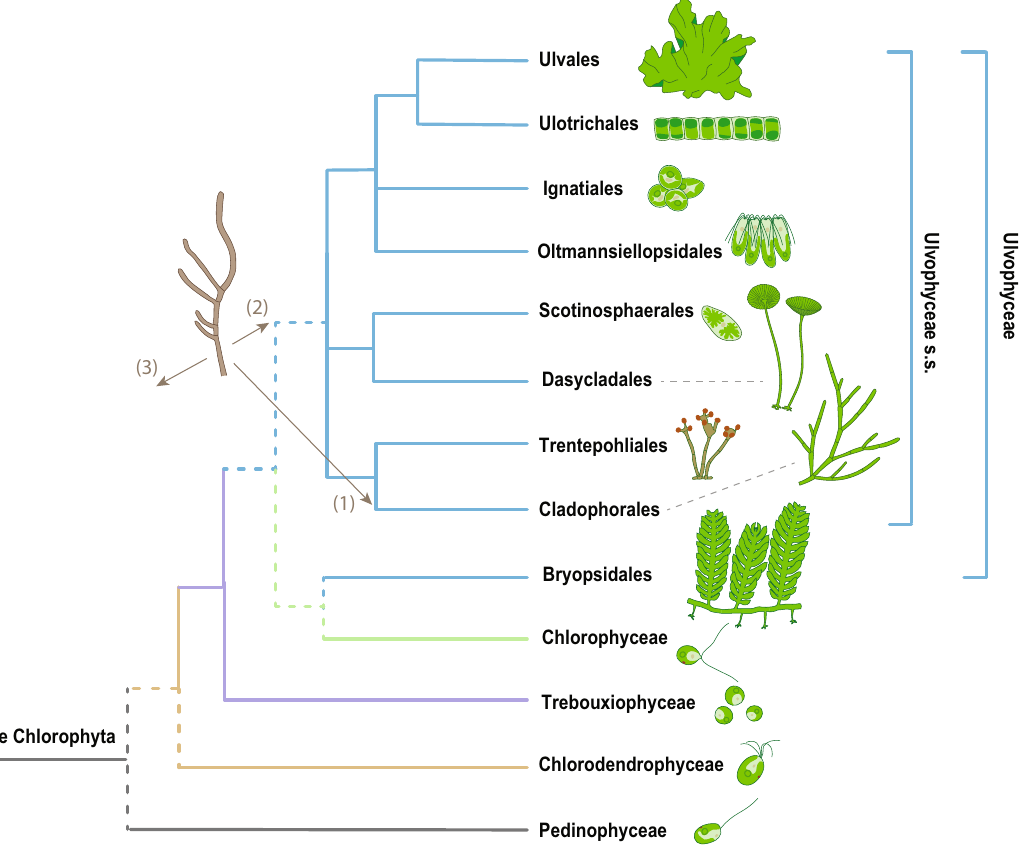
Fig. 1 Current knowledge of the phylogenetic relationships among the main lineages of the core Chlorophyta based on nuclear phylogenomic studies 17,18,20 . Uncertain phylogenetic relationships are indicated by polytomies or dashed lines. The three different interpretations of the Proterocladus antiquus fossil, corresponding to the three strategies used in our dating analyses, are indicated with arrows: (1) Proterocladus as a total-group cladophoralean, (2) Proterocladus as a total-group ulvophycean, and (3) uncertain phylogenetic position (within or outside the green